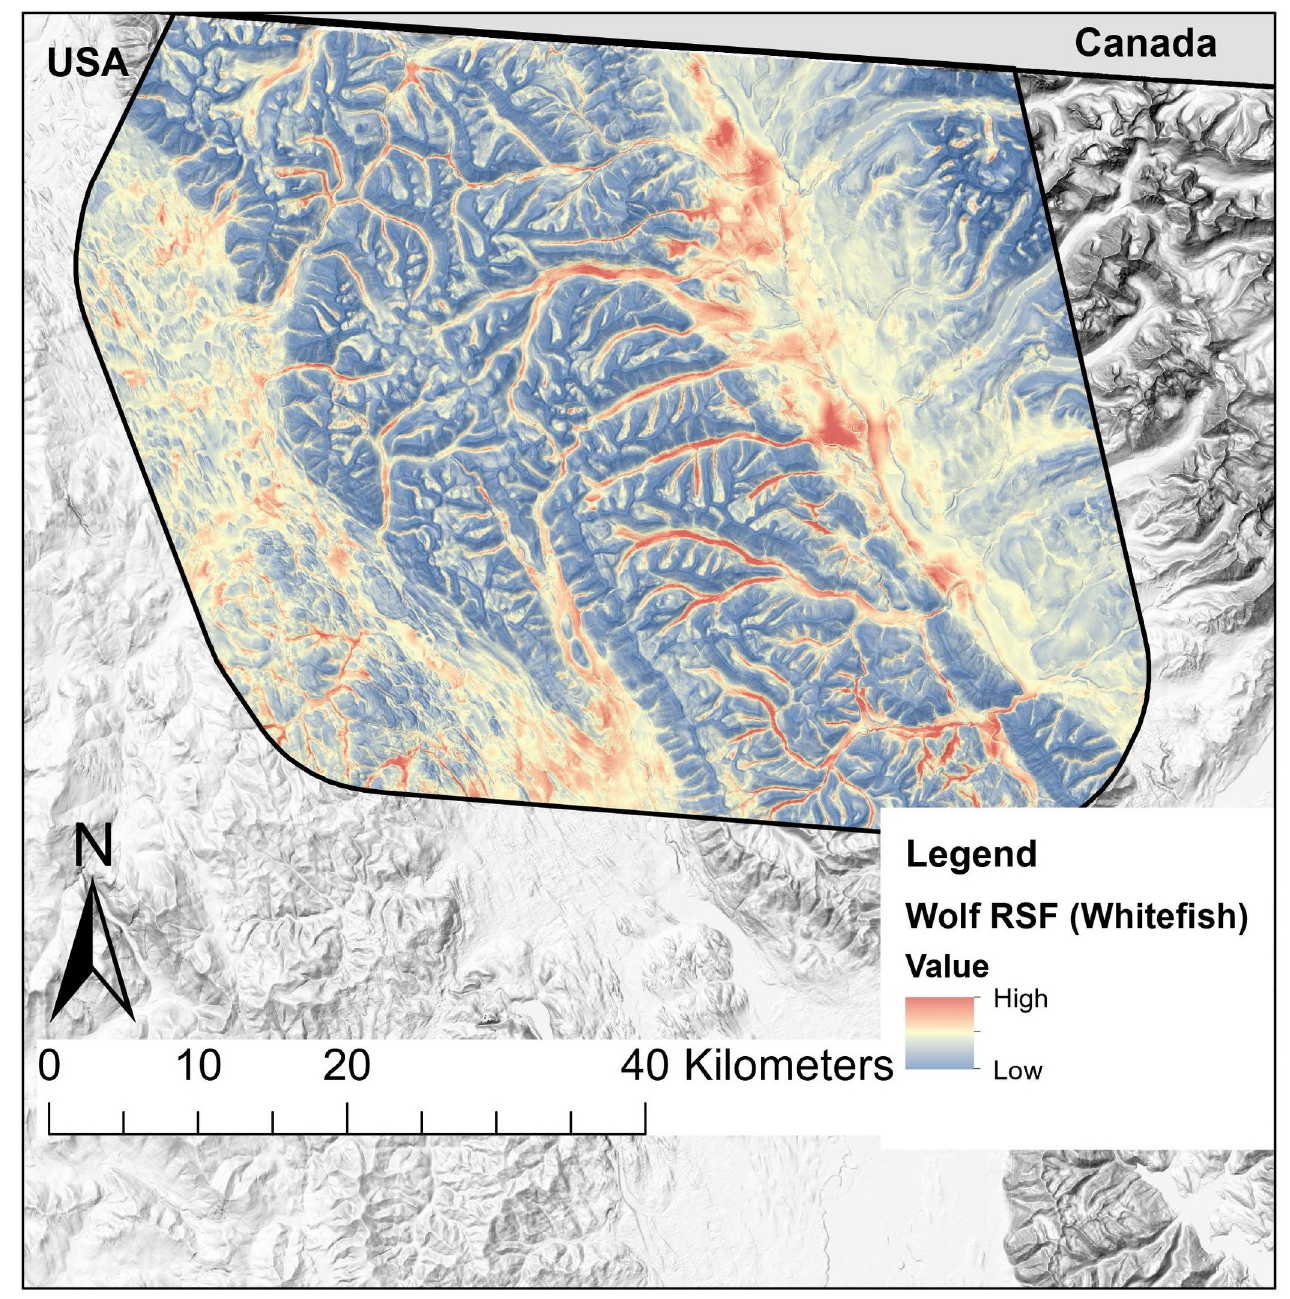
Fig 8. Map of wolf resource selection function in the Whitefish Range. Predicted relative probability of selection during summer from top-performing resource selection function (RSF) for wolves in the Whitefish Range, MT, USA. Reprinted from Montana hillshade map under a CC BY license, with permission from Montana State Library, original copyright